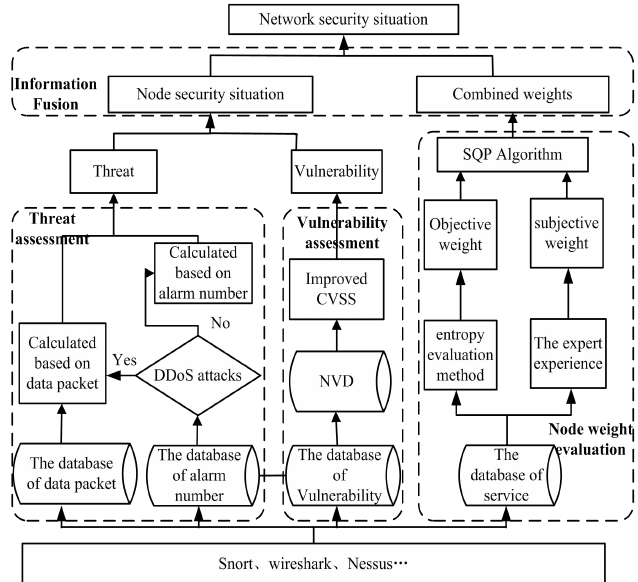
Figure 1: The model framework based on fusion